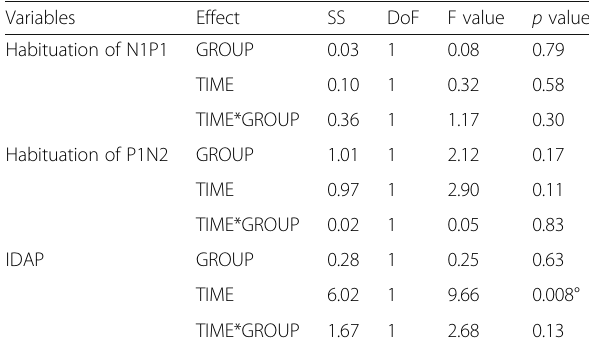
Table 2 Time effect of neurophysiological parameters between Responders and Non-responders